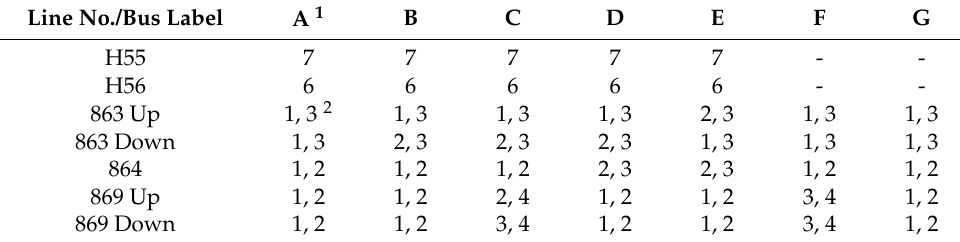
Table 7. Optimized charging schedule for each